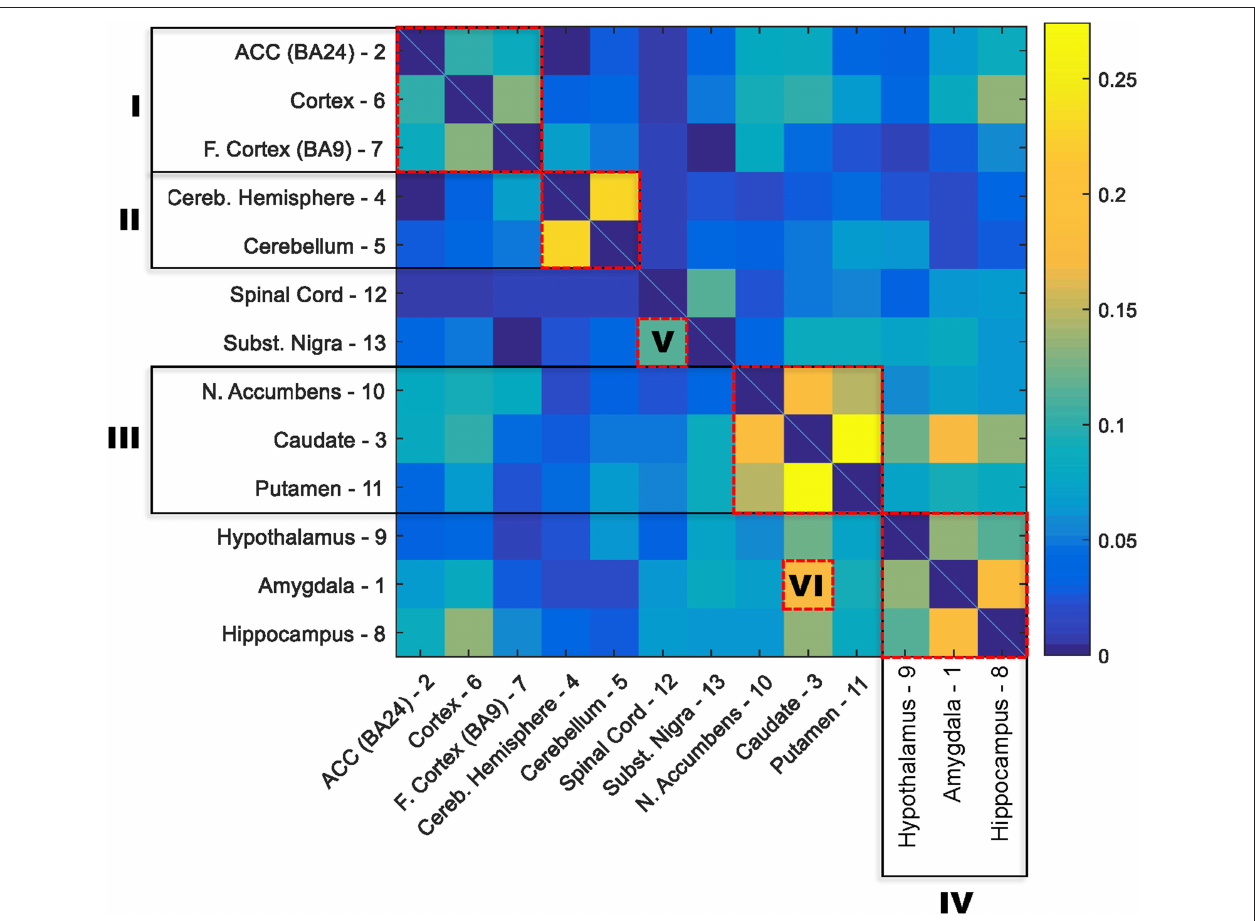
FIGURE 1 | Correlation matrix for the responsiveness of genes to aging between 13 GTEx brain regions. The responsiveness to aging of a gene was measured with the P -value for slope coefficient in the linear regression model between age and gene expression. The correlation between each two brain regions was estimated with the nonparametric Spearman rank correlation coefficient between P -values of all genes in the two regions. The order of regions in the matrix was rearranged based on the similarity between regions. Six clusters of highly correlated regions are highlighted with red boxes: I, cortex; II, cerebellum; III, basal ganglia; IV, hypothalamus, amygdala, and hippocampus; V, substantia nigra and spinal cord; and IV, amygdala and